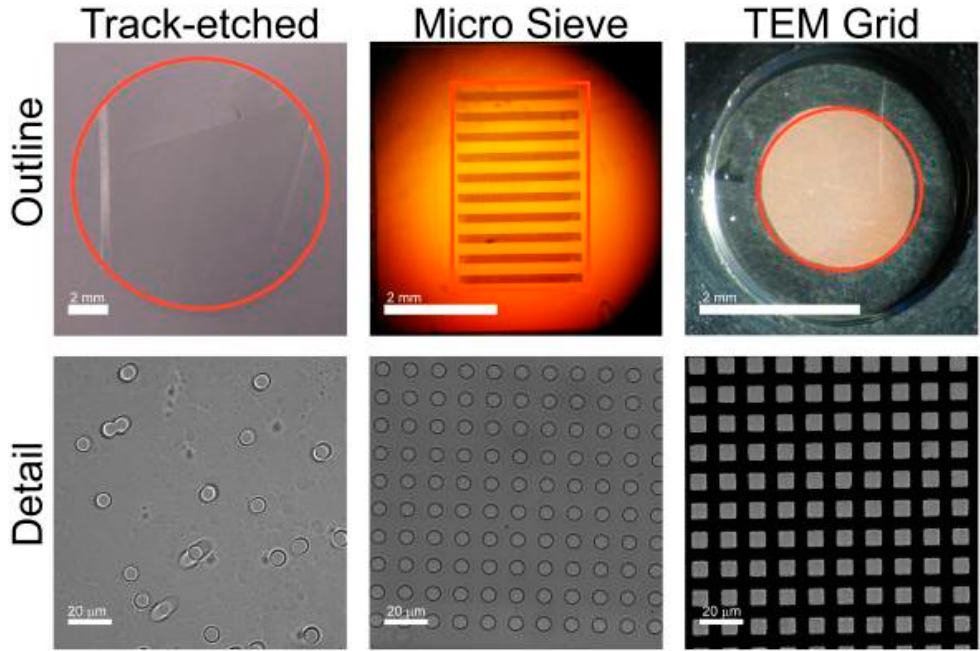
Figure 7. The outline images show a photograph of the track-etch filter, the microsieve and the TEM grid. The perforated area of each filter is indicated in red. The microsieve contains perforated horizontal bars alternated by support bars, giving rise to the horizontal pattern. The detail shows dark field images for the three filters. Spacing of the pores is random for the track-etch filters, leading to occasional double pores. Microsieves and TEM grids have periodical pore spacing. (Reprinted from [56]).